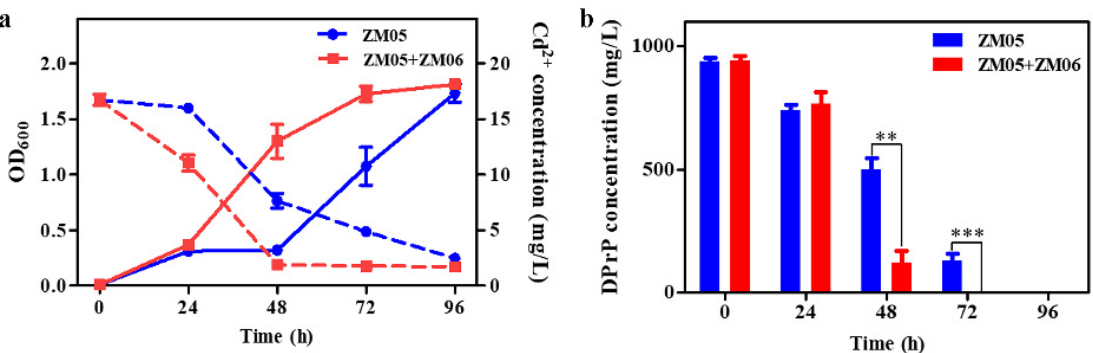
Figure 1. Growth and Cd(II) concentration ( a ) and DPrP degradation ( b ) in monoculture and coculture under Cd(II) contamination. The blue line (column) represents the monoculture of strain ZM05; the red line (column) represents the coculture of strains ZM05 and ZM06. The solid line represents the OD 600 , and the dotted line represents the residual concentration of Cd(II) in the supernatant. All data are presented as the mean ± SE. *** p < 0.001, ** p < 0.01.